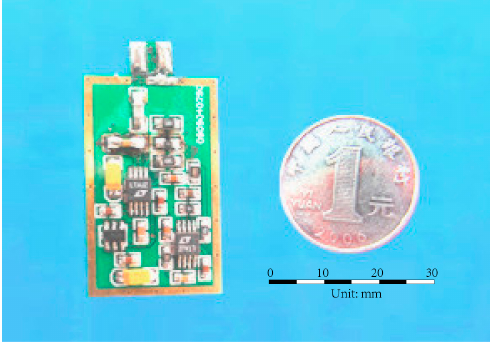
Figure 12. Charge amplifier.